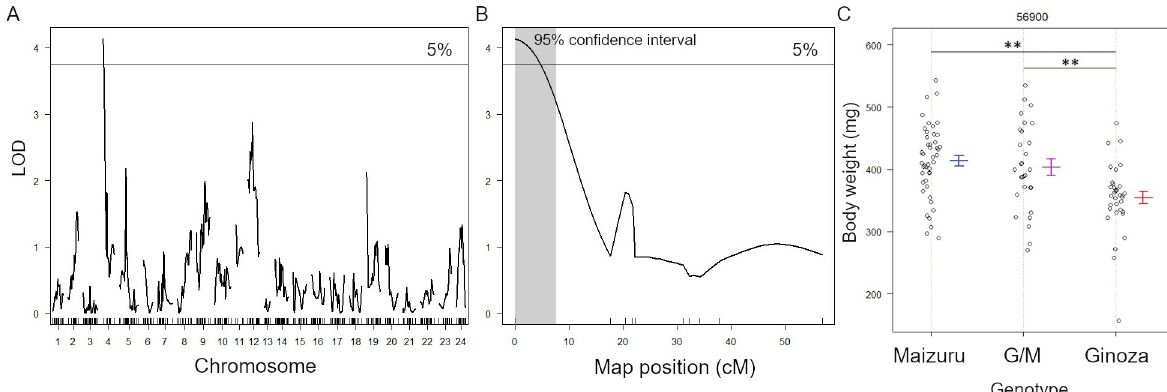
Fig 4. QTL analysis of the F 2 generation. (A) Results for all chromosomes. The significant QTL on chromosome 4 (B) has a peak LOD of 4.14. Gray areas indicate 95% Bayesian CI. (C) Body weight for genotypes of SNP marker 56900, which had the highest LOD score among the markers. Points represent the body weight of the F 2 individuals homozygous for the Maizuru alleles (n = 29), heterozygous for the Ginoza and Maizuru alleles (G/M, n = 46), and homozygous for the Ginoza alleles (n = 34). The means and standard errors (SE) are presented for each genotype. Differences between the mean body weight of the Ginoza and G/M genotypes and of the Ginoza and Maizuru fish were statistically significant ( � p < 0.01, ANOVA and Tukey’s honestly significance difference (HSD) test) but those between the G/M and Maizuru fish were not.